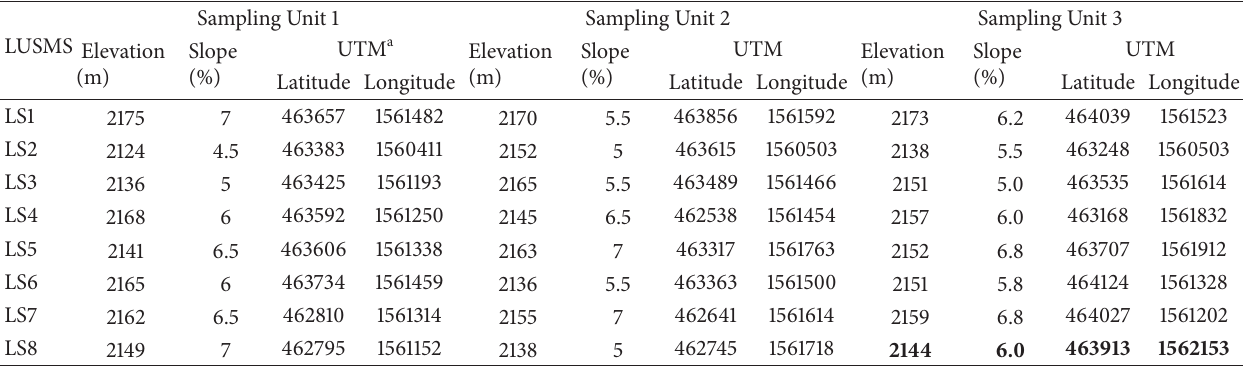
Table 1: Topographic characteristics of each sampling unit in the eight LUSMS selected for soil quality assessment within the Mai-Negus catchment in northern Ethiopia.